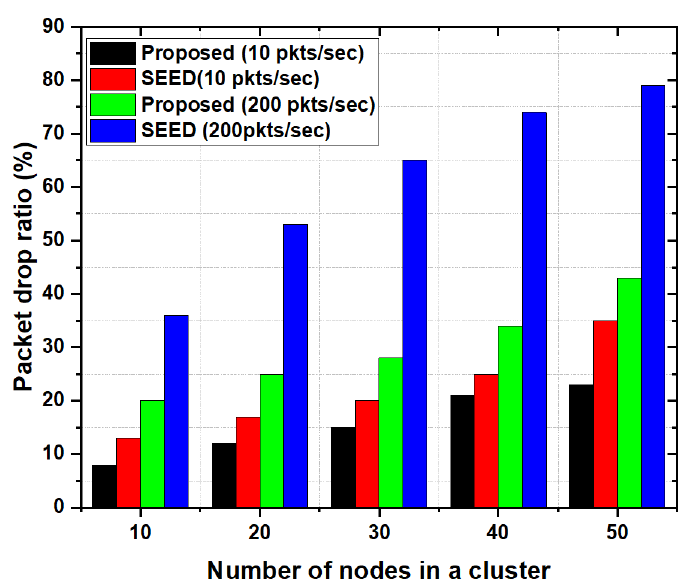
Figure 8. Packet drop ratio as a function of the number of nodes in a